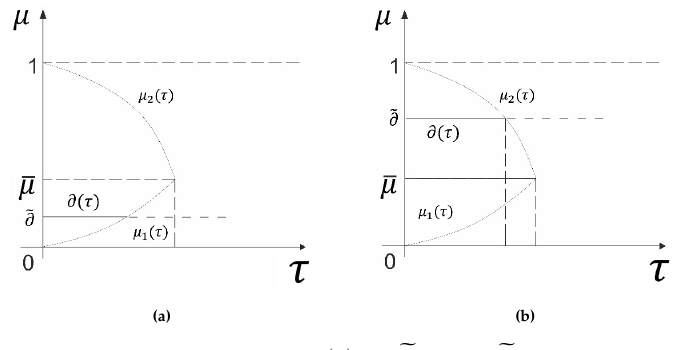
Figure 4. Function ∂(τ) : ( а ) ∂(cid:3562) < μ(cid:3364) ; ( b ) ∂(cid:3562) > μ(cid:3364).